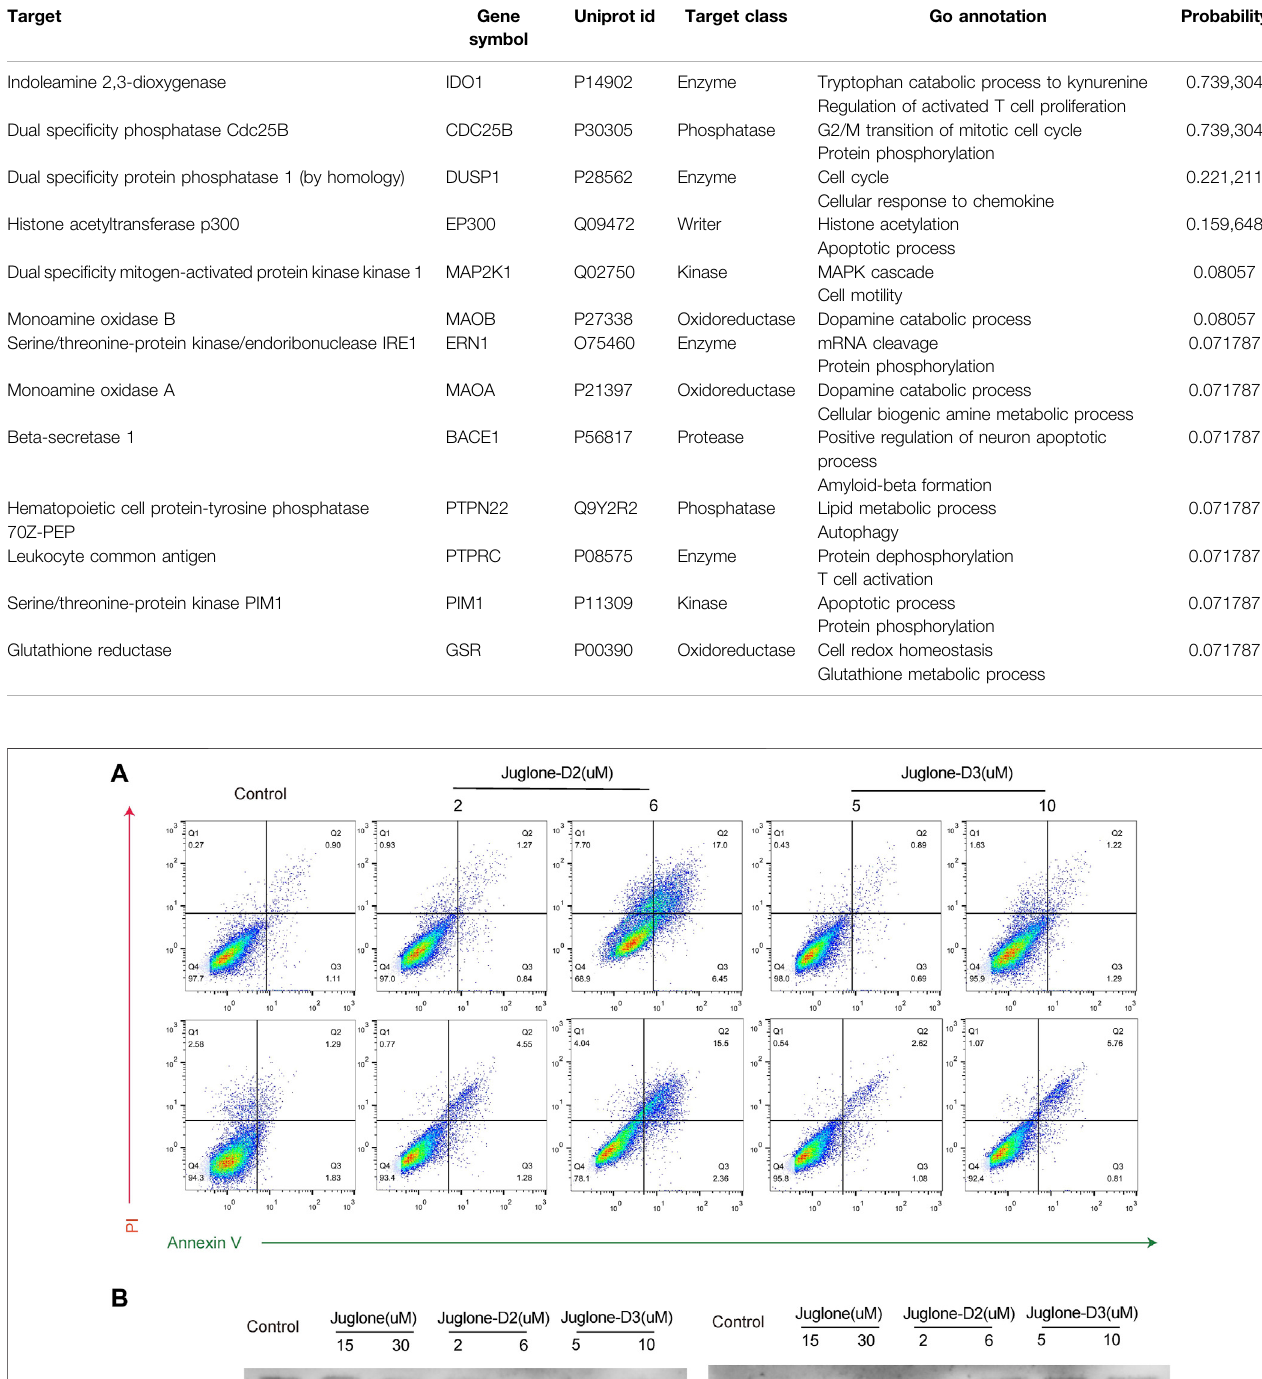
Frontiers in Pharmacology |